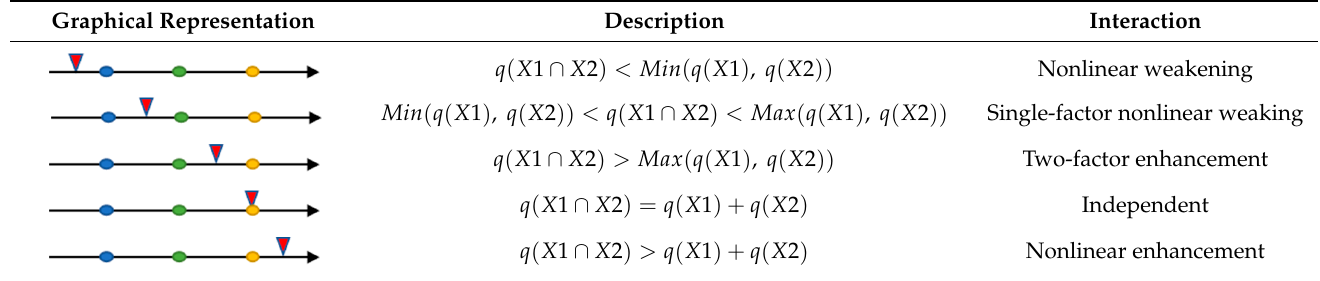
Table 2. Types of interaction between two covariates. Graphical Representation Description Interaction